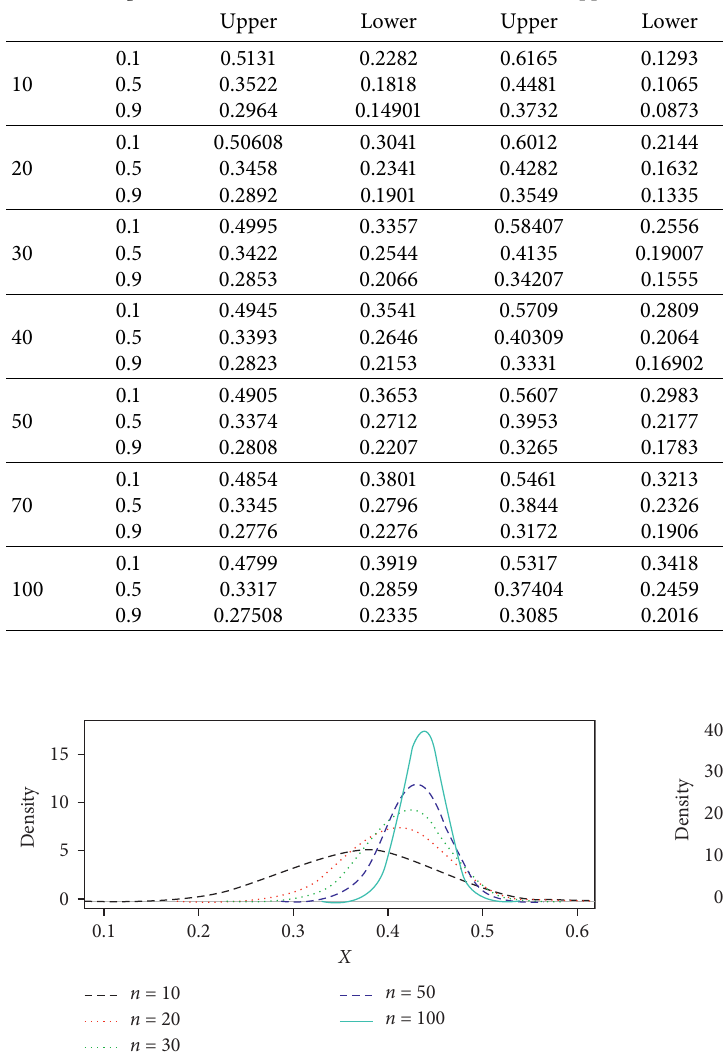
Figure 3: The estimated PDF’s of R 0 . 9